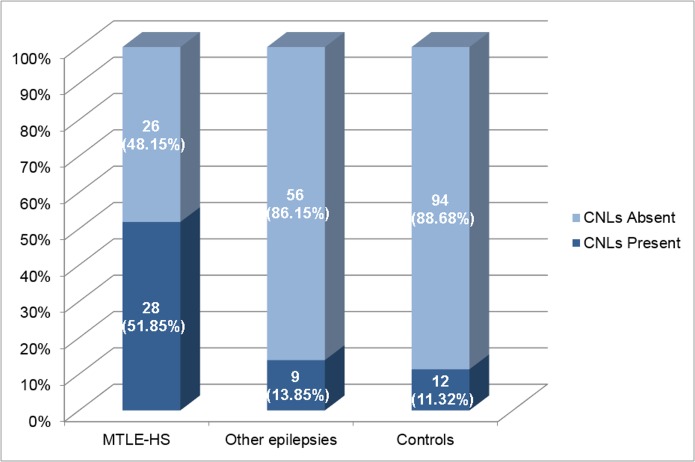
Total Number of Subjects with calcified neurocysticercotic lesions on CT scans.This graph shows the percentage of subjects with calcified neurocysticercotic lesions in each subgroup (MTLE with HS, other epilepsies, disease controls). MTLE-HS = Mesial temporal lobe epilepsy with hippocampal sclerosis, CNLs = Calcified neurocysticercotic lesions.